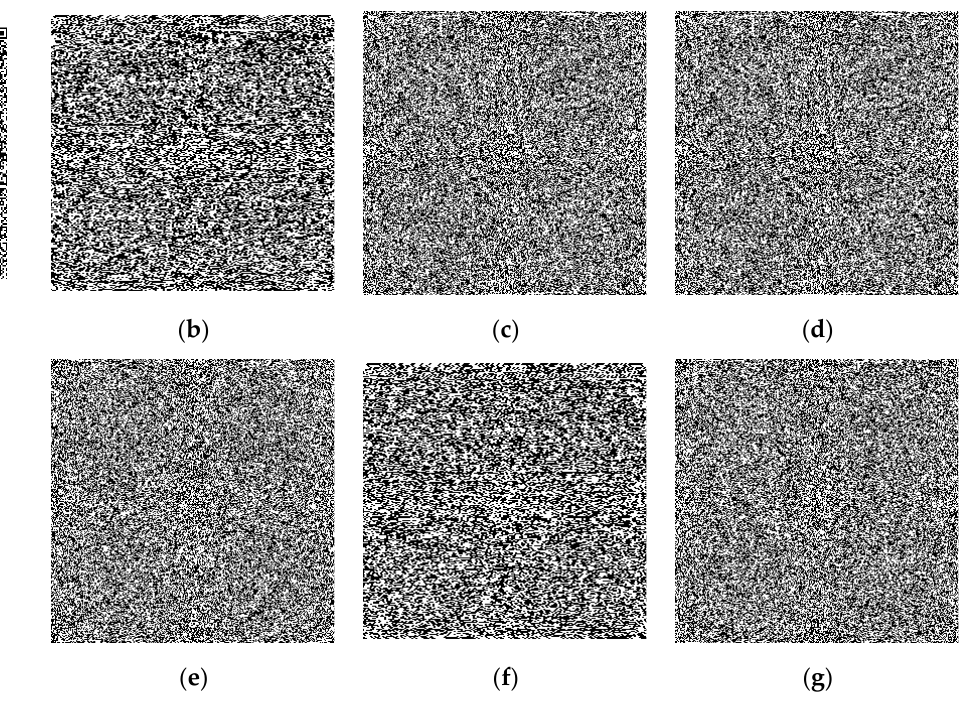
Figure 8. ( a ) The original QR code and its decrypted versions using the following wrong KEY parameters: ( b ) α 1 = α + ∆ , ( c ) β 1 = β + ∆ , ( d ) δ 1 = δ − ∆ , ( e ) ϕ 1 = ϕ + ∆ , ( f ) x 1 = y − ∆ , with ∆ = 10 − 15 ( g ) y 1 0 0